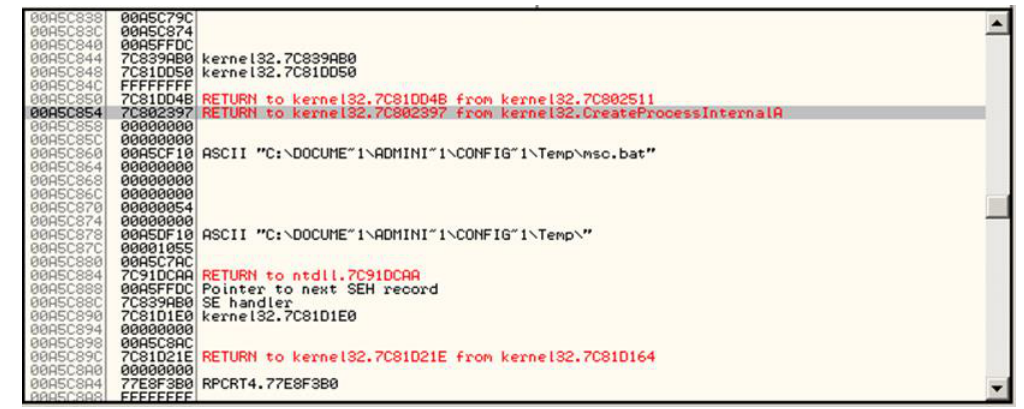
Figure 13. Creation of the file “MSC.bat”.